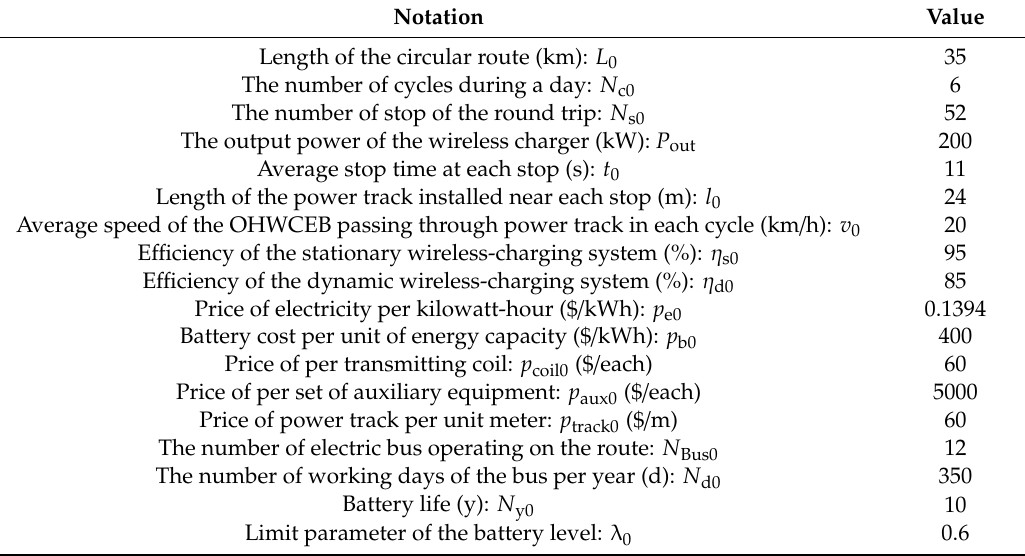
Table 2. The input parameters for the numerical example.